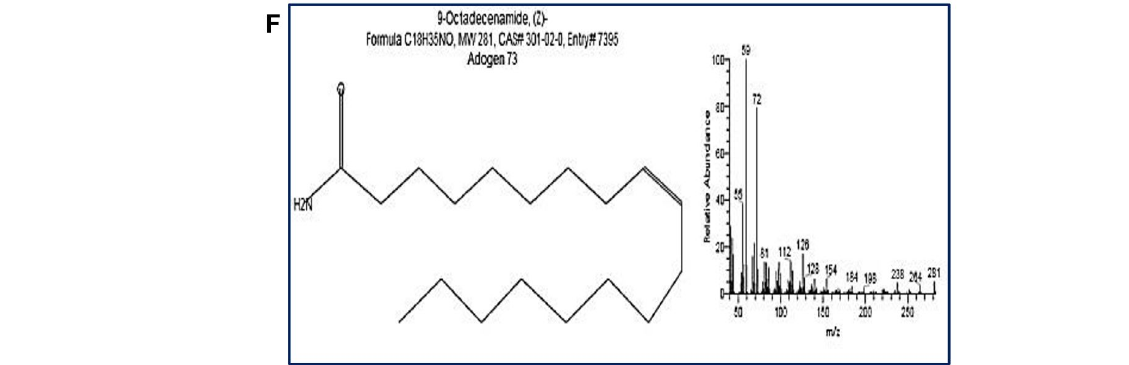
Figure 7 . GC–MS analysis of extracted soil sample containing cypermethrin (2500 mg kg − 1 ). Panel ( A ) is control (extract from soil containing cypermethrin without bacterial inoculation); panels ( B – F ) are extracted from soil samples containing cypermethrin and inoculated by L. cresolivuorans HIS7. Table 1. GC-MS analysis of extracted soil sample containing cypermethrin (2500 mg kg − 1 ) in the absence (control) and presence of L. cresolivuorans strain HIS7.